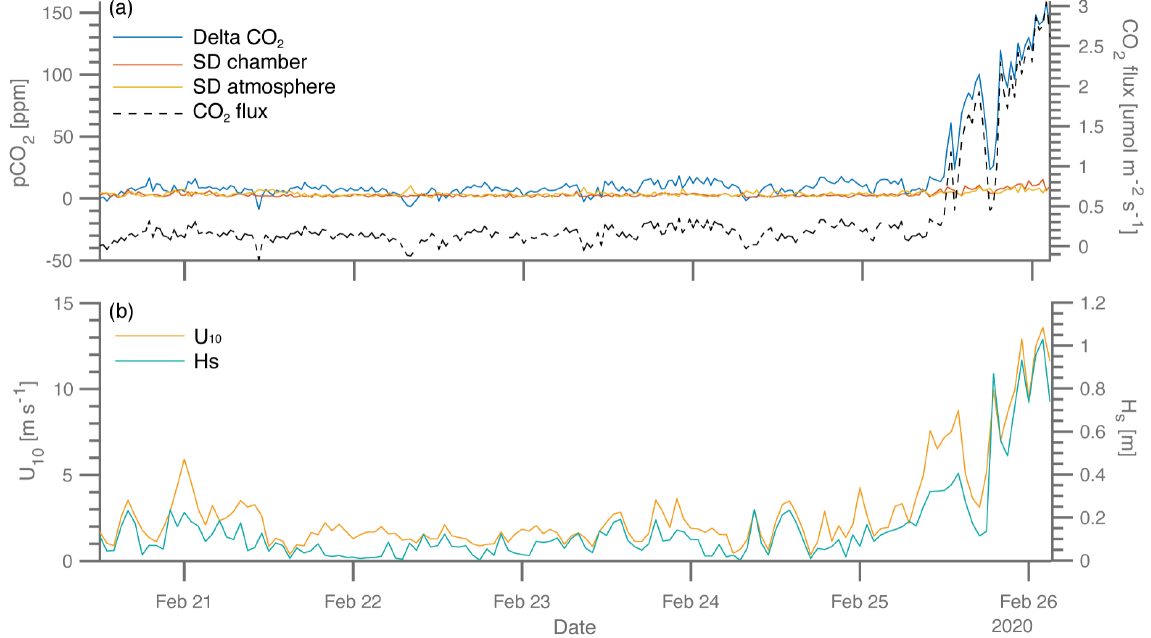
Figure A4. (a) Raw outputs of the eosFD during one period of CO 2 flux measurements, showing the (cid:49) CO 2 between both cavities of measures (atmosphere cavity and chamber cavity) (blue line); the standard deviation of each cavity between two automated flushing events (30min of interval) – chamber cavity (red line) and atmosphere cavity (yellow line); and the CO 2 flux (black dash line). (b) Temporal evolution of U 10 and H s during the same period as the CO 2 flux measurements. The increase in flux on 25 February corresponds to the increase in wind speed and waves.